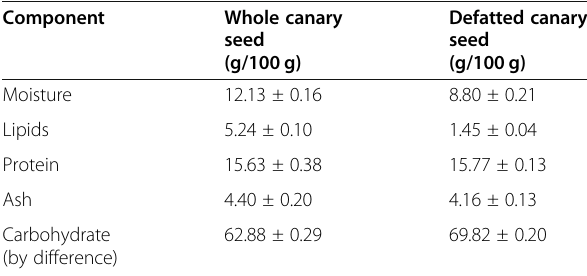
Values are mean ± standard deviation of triplicate